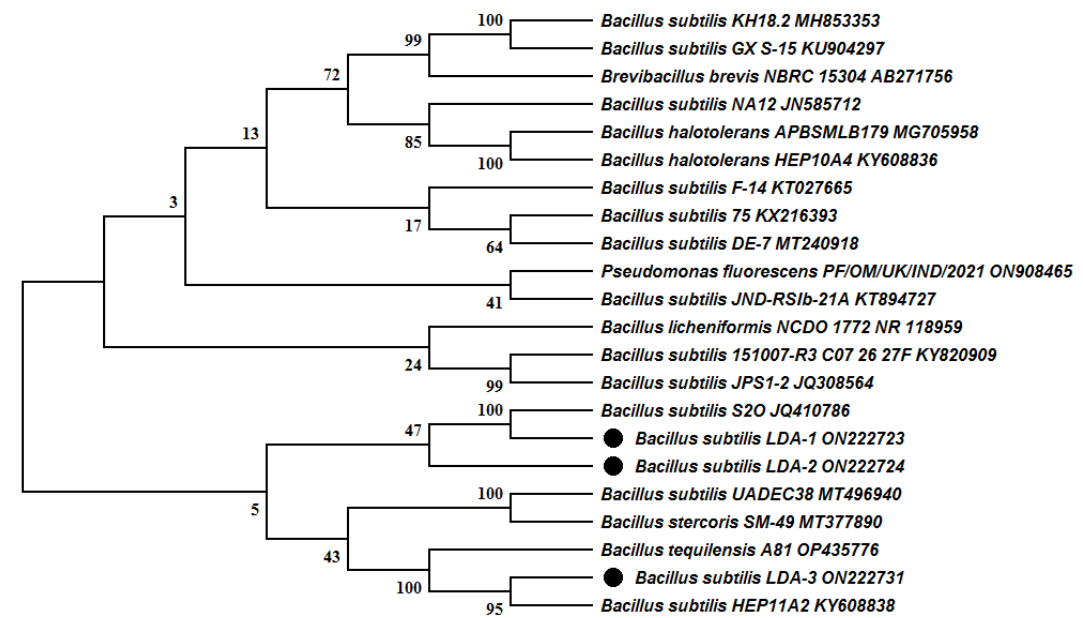
Figure 1. Neighbor-joining phylogenetic tree (values at branching points indicate bootstrap) based on 16S rDNA sequences of isolated Bacillus subtilis strains LDA-1, LDA-2, and LDA-3. (bootstrap values expressed as percentages of 1000 replications).